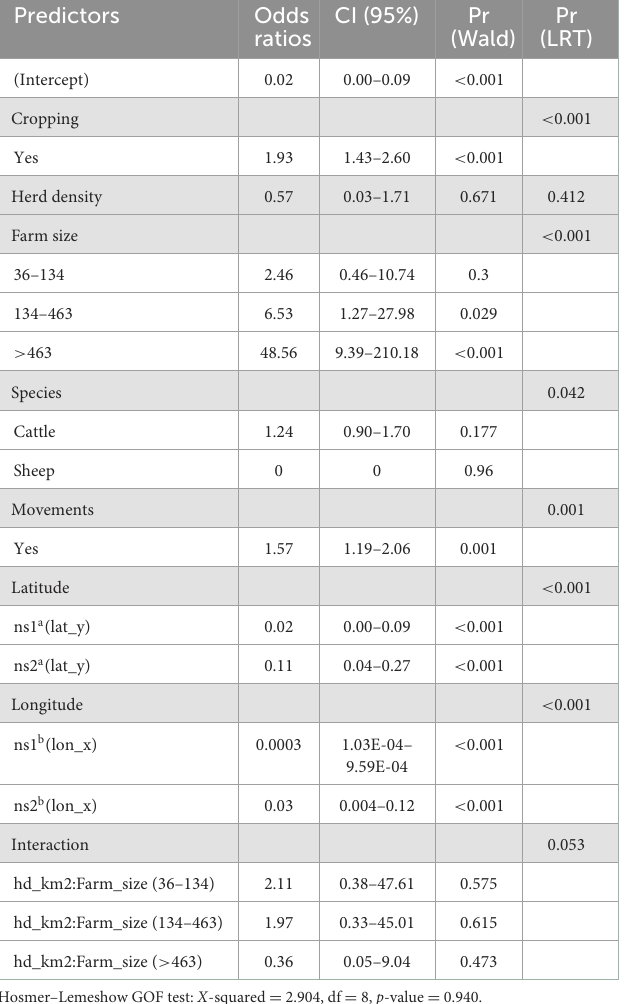
TABLE 4 Multivariable logistic regression output (OR: odds ratio) for the high-risk period (HRP).